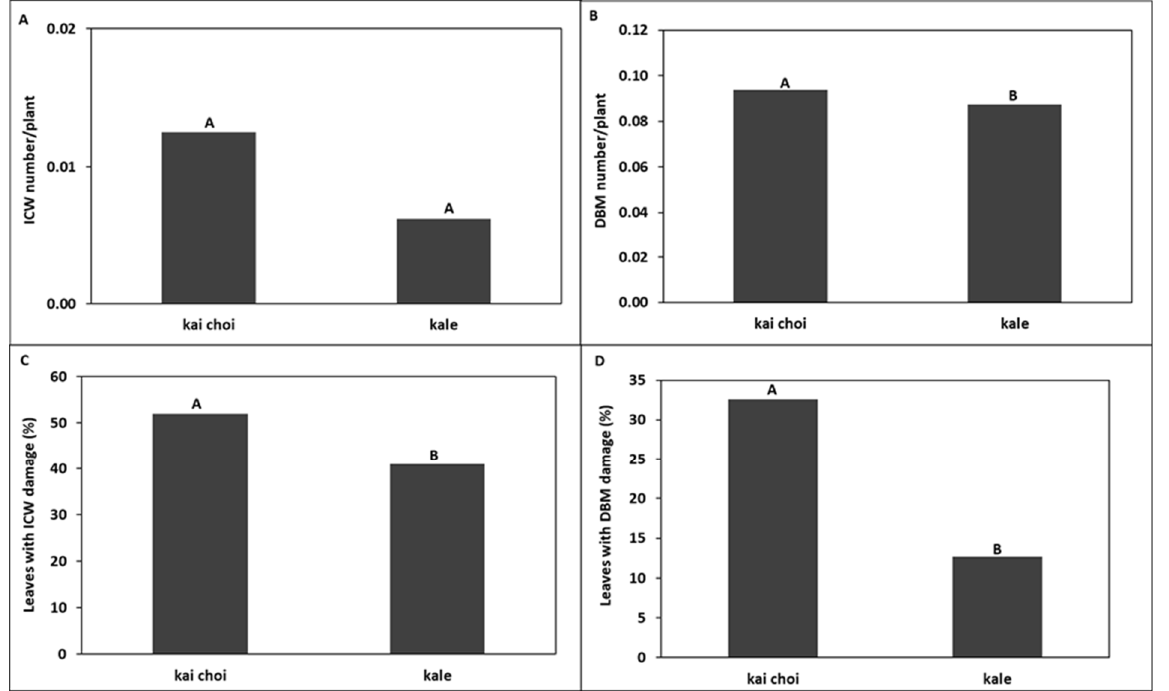
Figure 16. Abundance of ( A ) ICW larvae; ( B ) DBM larvae; ( C ) ICW leaf damage; ( D ) DBM leaf damage on kai choi and kale in Trial II. Means followed by the same letters in a graph are not different based on analysis of variance.